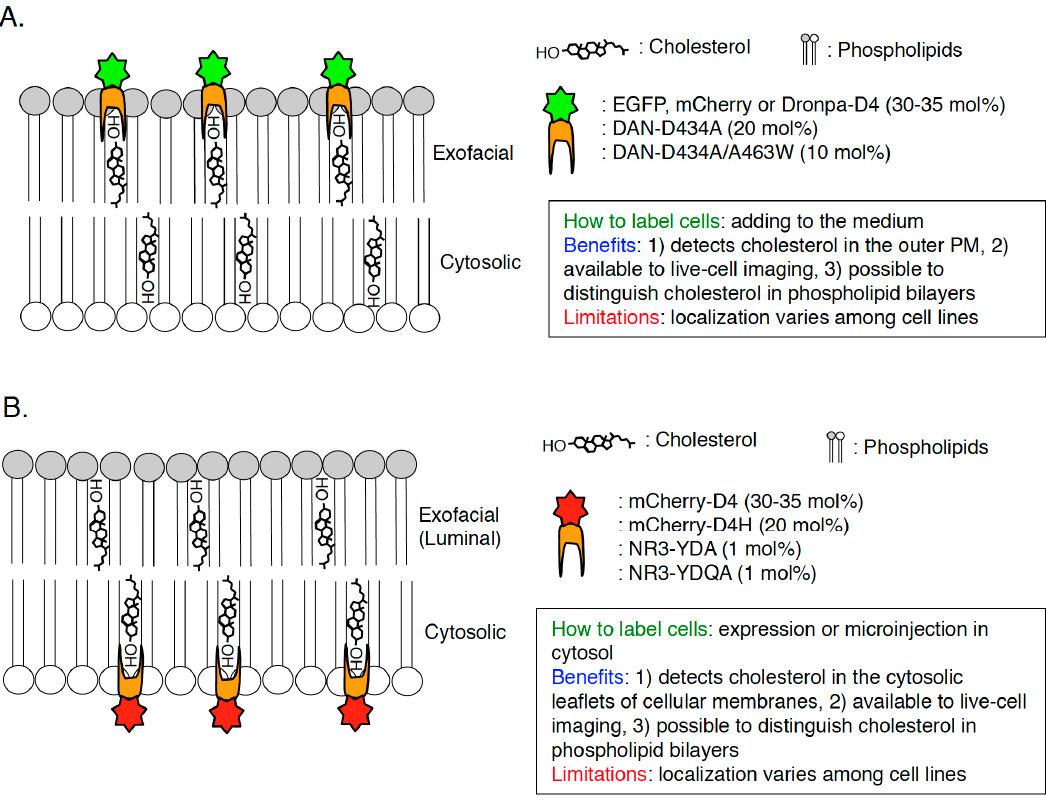
Figure 4. Scheme of visualization of cholesterol in cellular membranes by D4-derived cholesterol biosensors. Scheme, methodology, benefits, and limitations of D4-derived cholesterol biosensors to visualize cholesterol in the exofacial leaflets of the PM ( A ) and cytosolic leaflets of cellular membranes ( B ) are shown. The number is cholesterol concentration (mol %) threshold required for each cholesterol probe-binding.